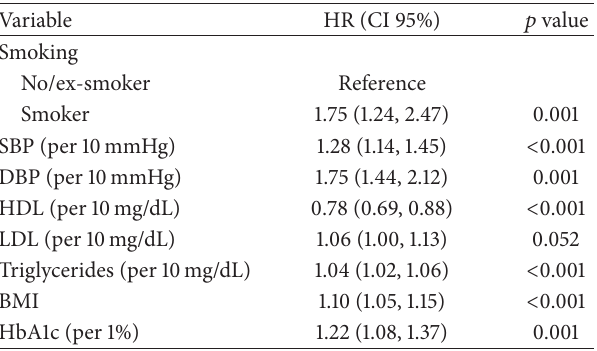
Table 4: Univariate analysis to analyze the association between time-dependent variables along the follow-up and the development of DR during the same period.